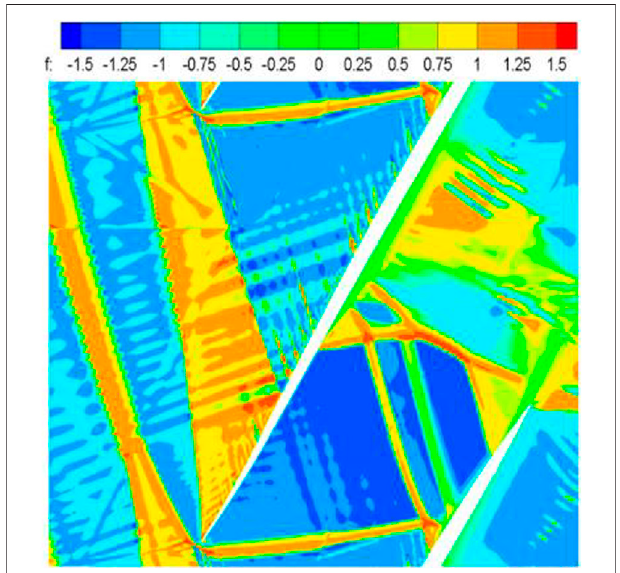
FIGURE 5 | Shock function contours of the cascade.